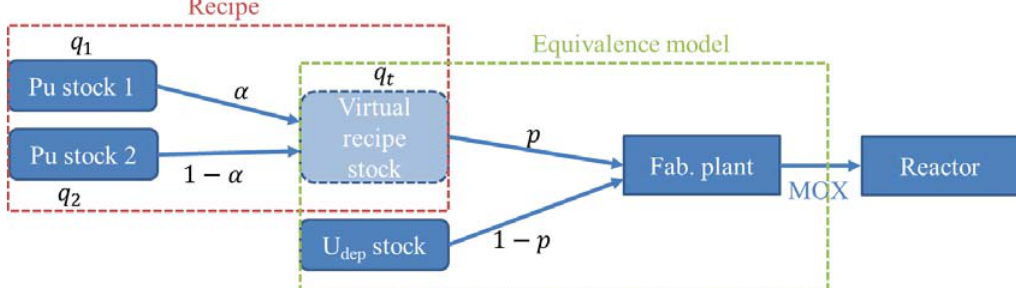
Figure 4. Recipe and equivalence processes in fresh fuel